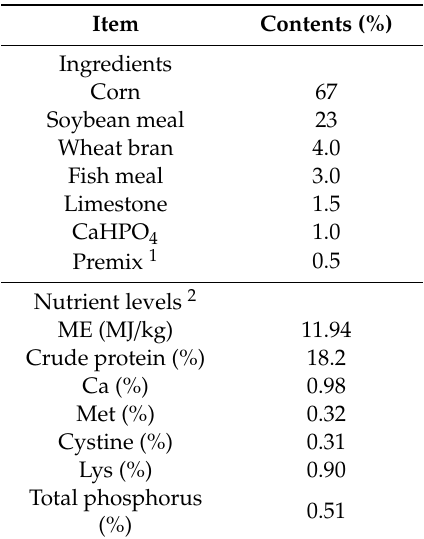
Table 1. Basal diet composition (as-fed